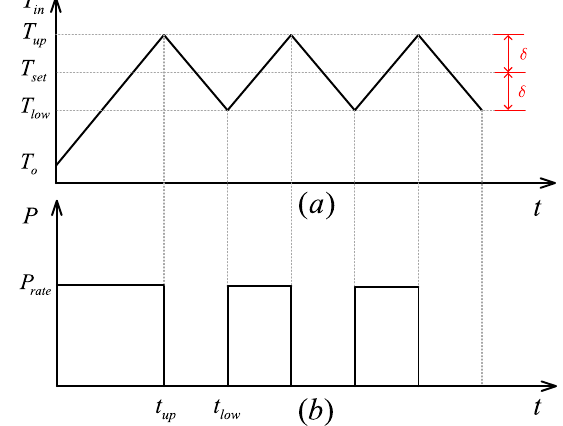
Fig. 3 Operation characteristics of the TCL in heating mode: ( a ) the varying curves of the indoor temperature and ( b ) the varying curves of the TCL ’ s power